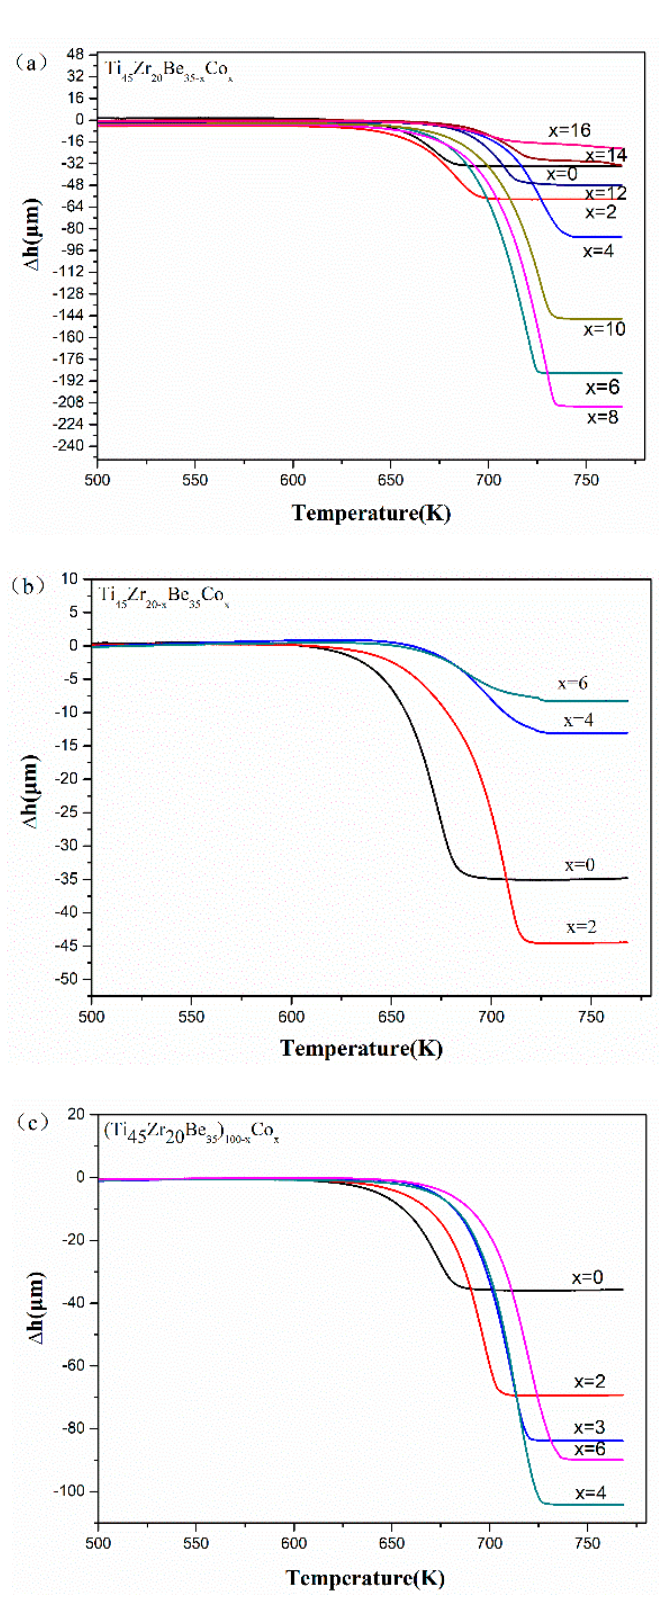
Figure 5. TMA results of ( a ) Ti 45 Zr 20 Be 35 − x Co x ( x = 0, 2, 4, 6, 8, 10, 12, 14, and 16), ( b ) Ti 45 Zr 20 − x Be 35 Co x ( x = 0, 2, 4, and 6), and ( c ) (Ti 45 Zr 20 Be 35 ) 100 − x Co x ( x = 0, 2, 3, 4, and 6) samples.